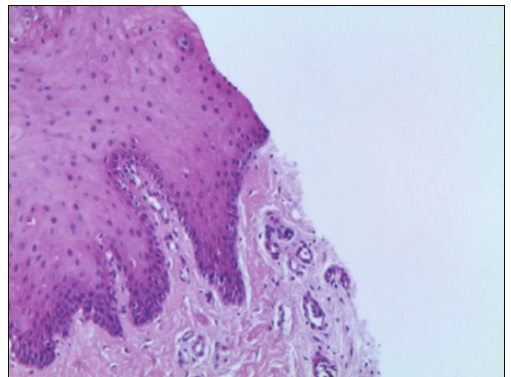
Figure 7: Histological specimen R, using cold-blade scalpel, colour EE, magnification from original